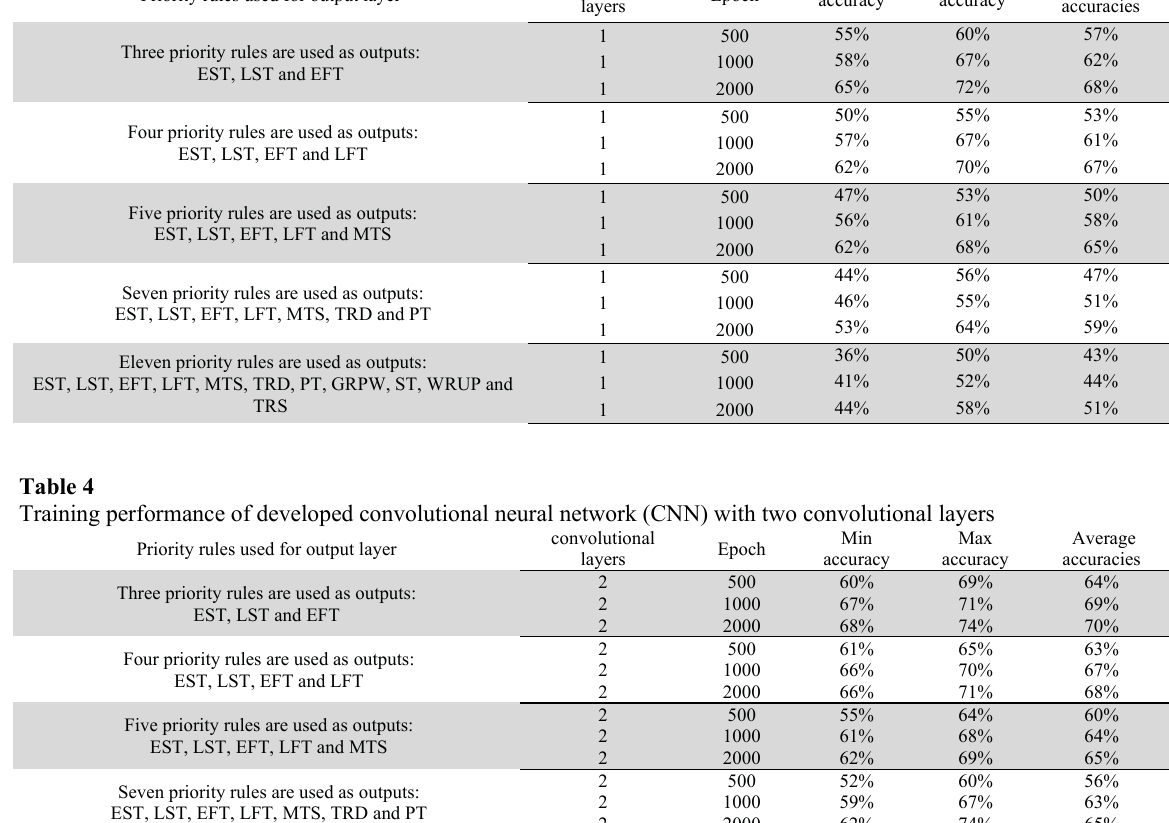
Min Max convolutional Average Epoch accuracy accuracy layers accuracies